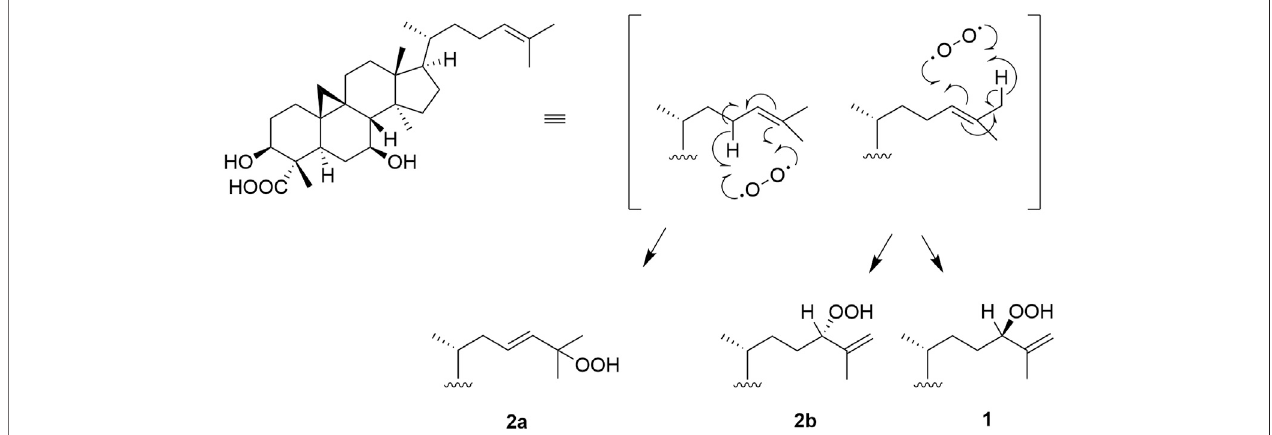
FIGURE 4 | Proposed pathway for the formation of the castaneroxys from the hypothetical precursor. Based on the pathway proposed by Banskota et al. (Banskota et al., 2000).